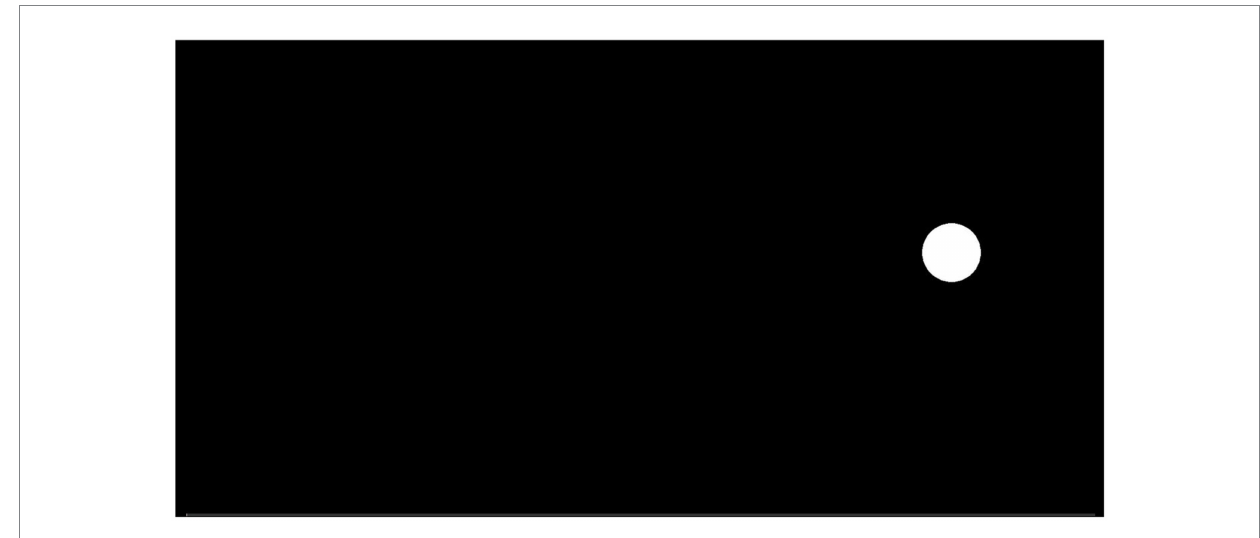
FIGURE 1 Picture of the object-tracking task. A white dot moved within the window for 60s and had to be visually tracked by the